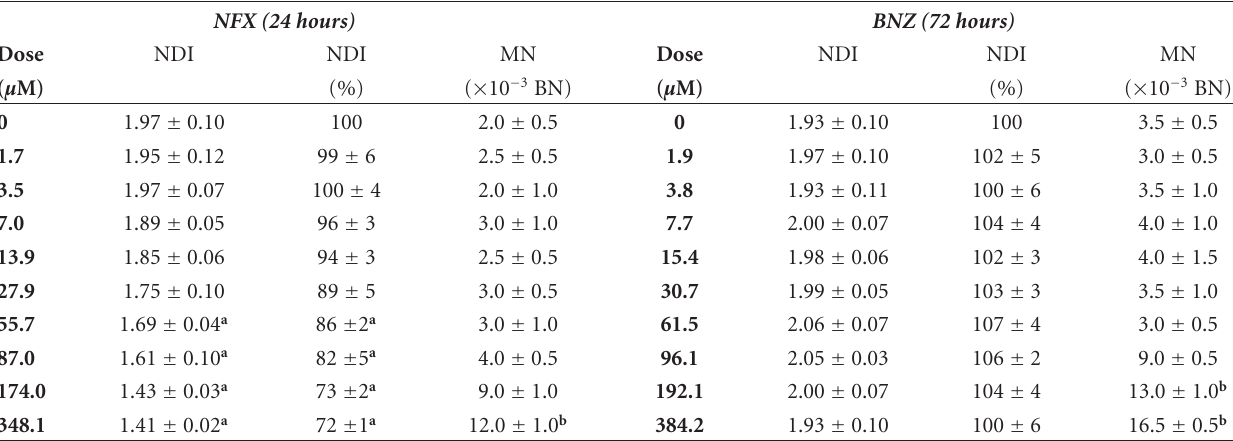
Table 3: Mean frequency of Micronuclei (MN) in binucleated cells and Nuclear Division Index (NDI) in human lymphocytes treated